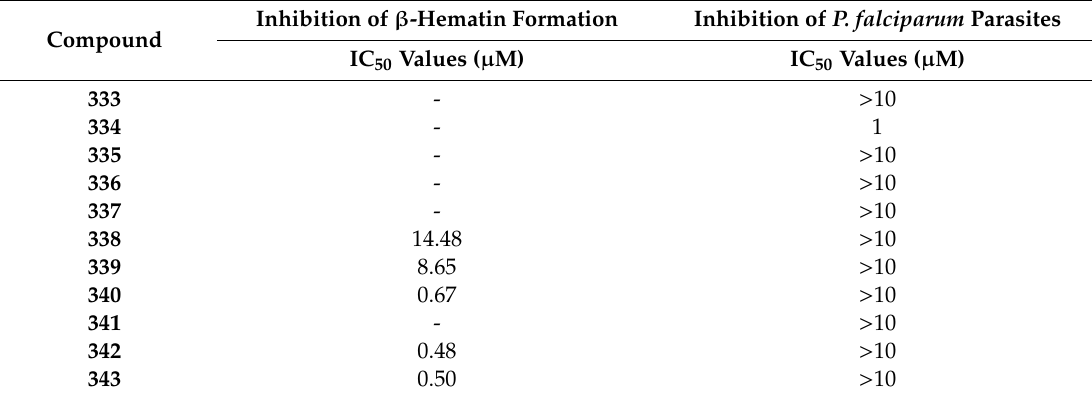
Table 41. E ff ects (IC 50 values in µ M) of compounds 333 – 343 on inhibition of β -hematin formation and activity against cultured Plasmodium falciparum parasites.